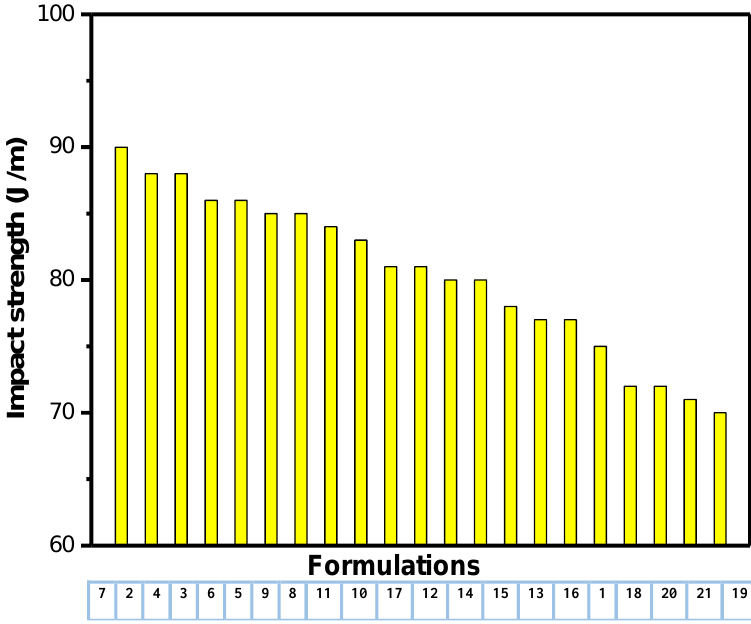
Figure 8. Impact strength versus formulations in a descending order.